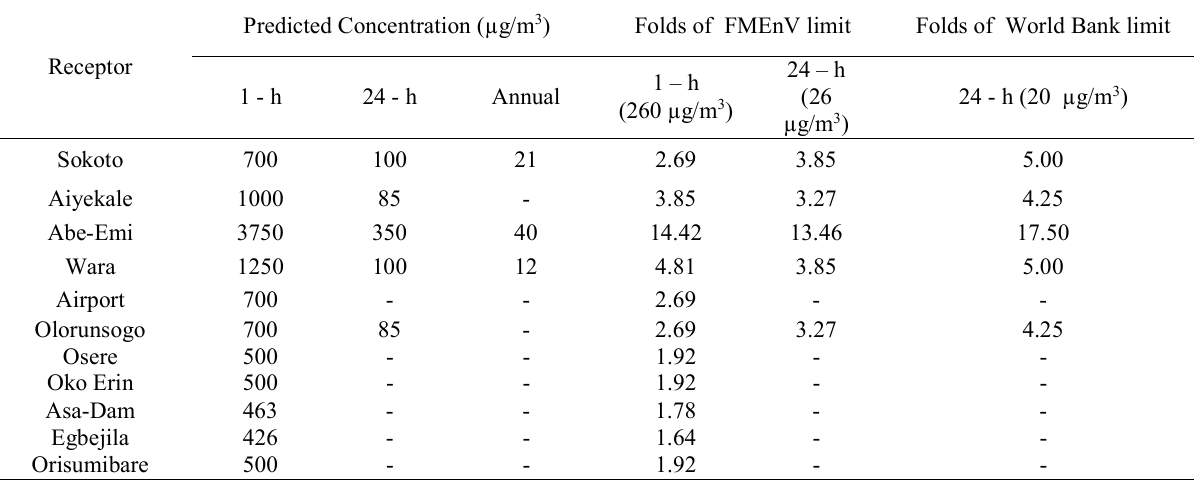
Table 5. Predicted cumulative impacts of SO X around Sokoto-Aiyekale dump